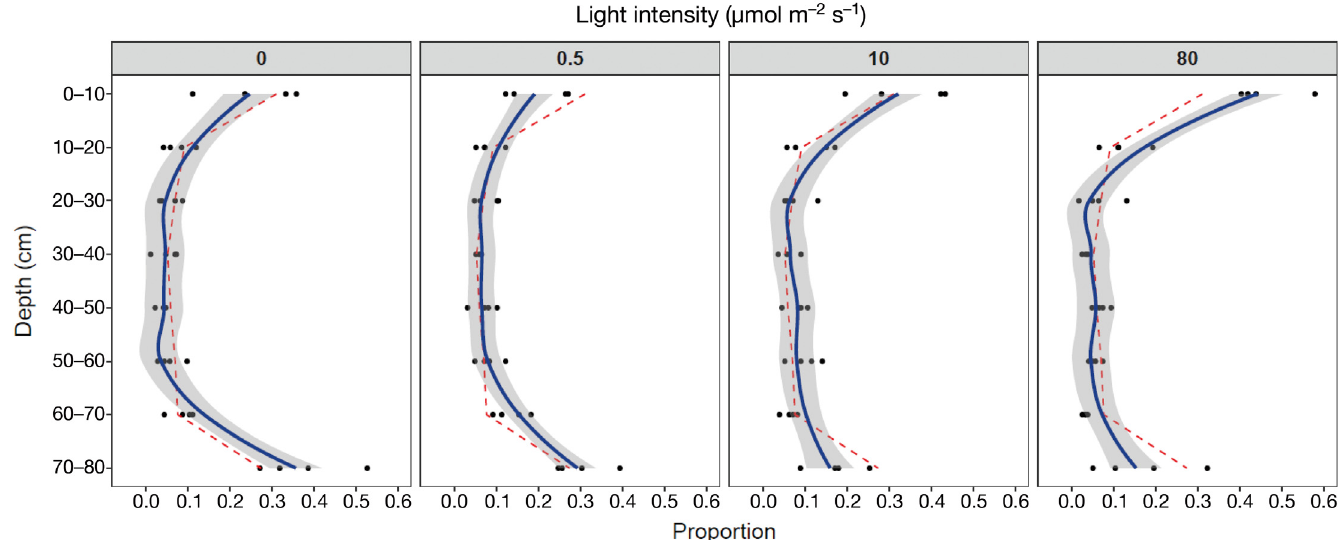
Fig. 5. Proportion of salmon lice Lepeophtheirus salmonis nauplii found in 10 cm increments of the column (0−80 cm) exposed to 0, 0.5, 10 or 80 μmol m −2 s −1 after 1 h. Points: individual data points; lines: smoothed loess average; shading: SE. Red dashed line: overall average used to compare distributions in generalised additive model